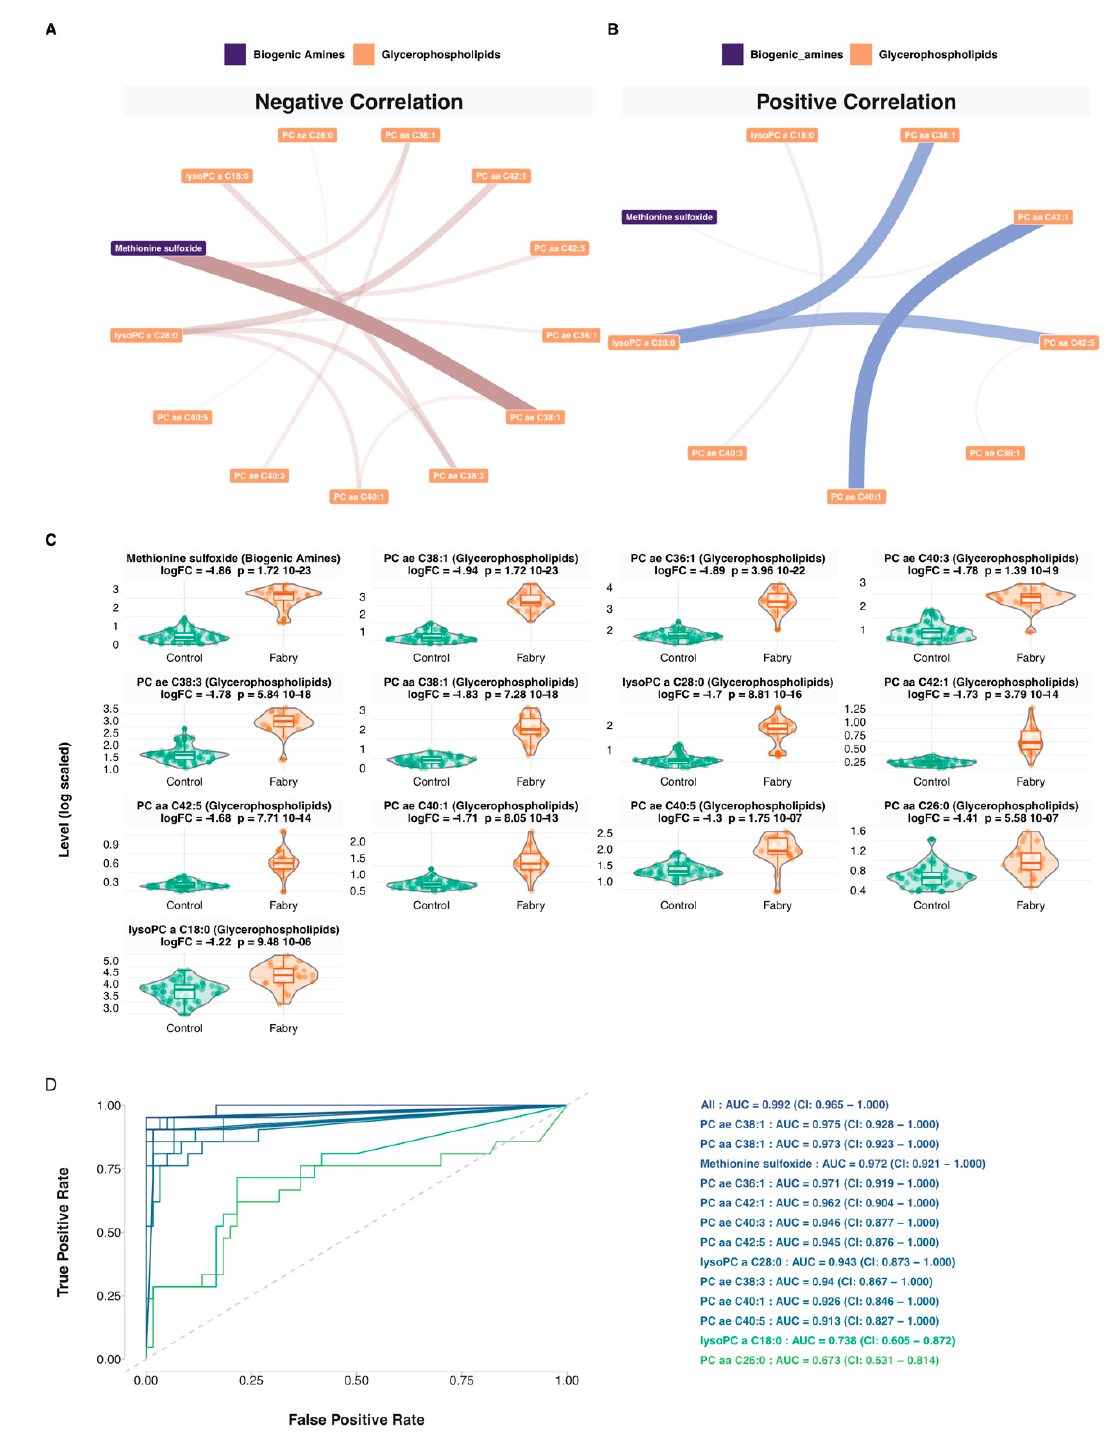
Figure 6. Network and machine learning analysis. ( A ) Negative partial correlation network visualization of the Fabry consensus plasma metabolic signature. The size of the ribbon is proportional to the correlation. ( B ) Positive partial correlation network visualization of the Fabry consensus plasma metabolic signature. The size of the ribbon is proportional to the correlation. ( C ) Boxplots of the consensus plasma metabolic signature. ( D ) ROC curves of the Random Forest predictive models, including 1 biogenic amine (Methionine sulfoxide), 2 lysophosphatidylcholines (lysoPC a C18:0, lysoPC a C28:0) and 10 glycerophospholipids (PC ae C38:1, PC aa C38:1, PC ae C36:1, PC aa C42:1, PC ae C40:3, PC aa C42:5, PC ae C38:3, PC ae C40:1, PC ae C40:5, PC aa C26:0).